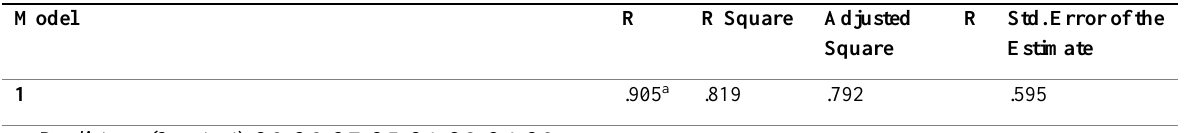
Table 1: Model Summary